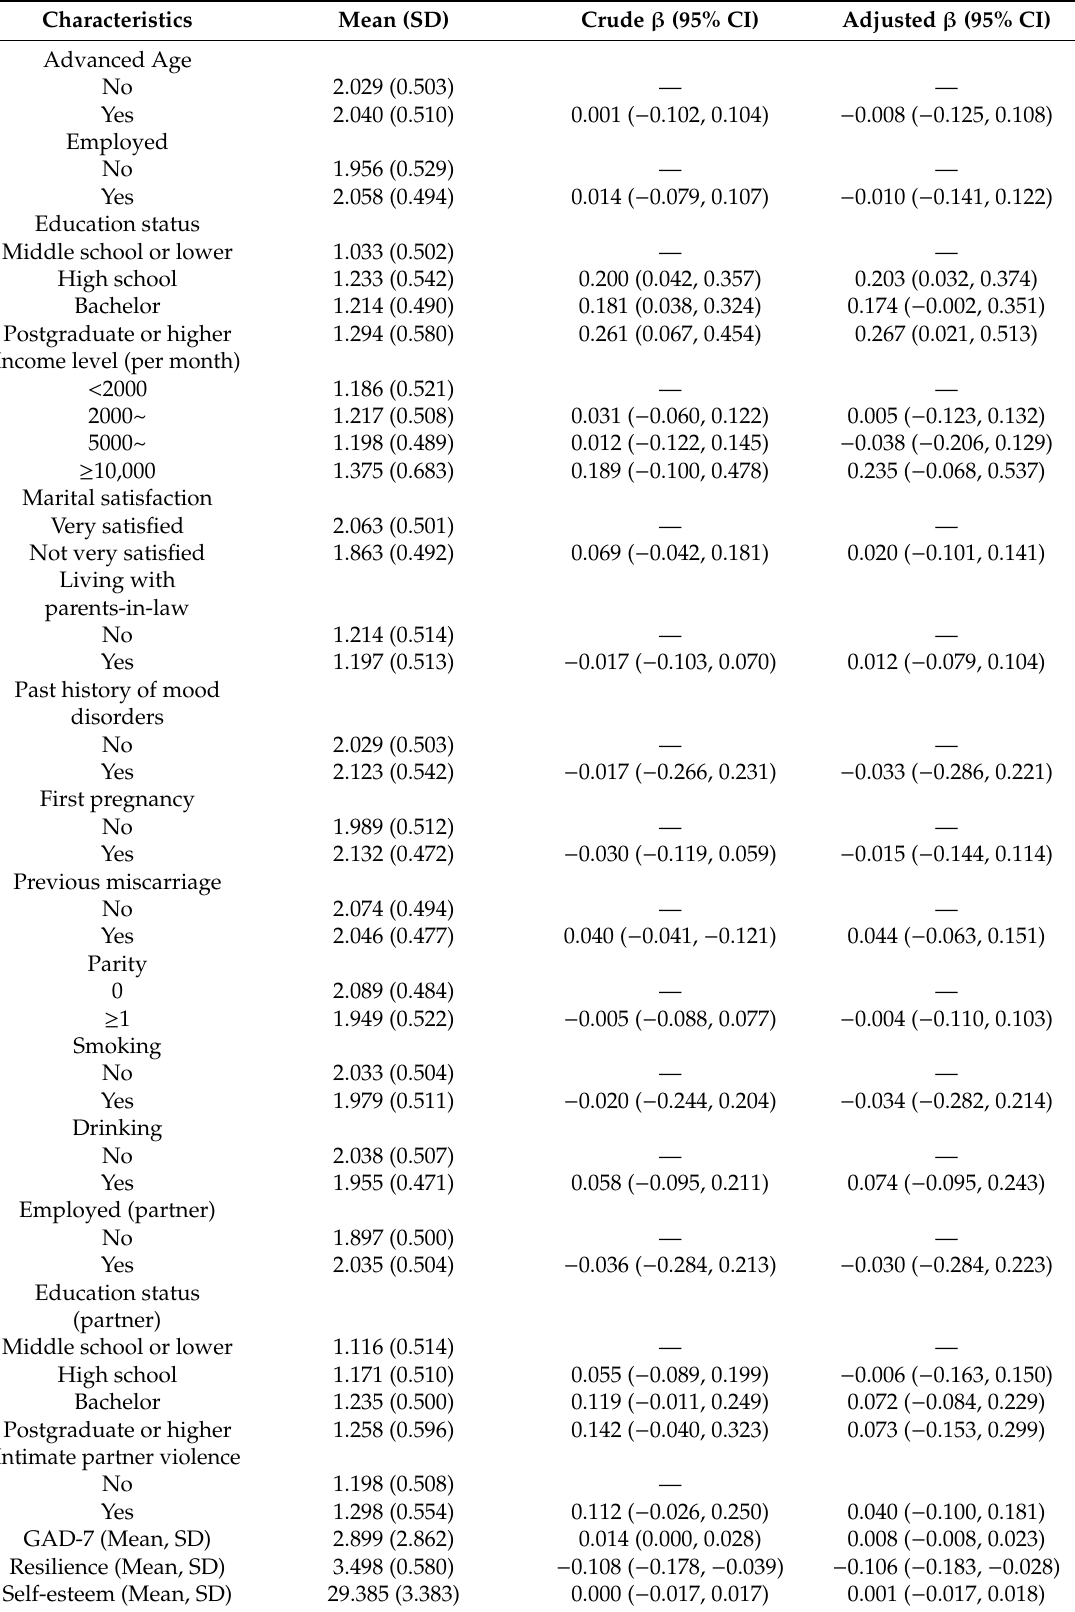
Table 4. Influencing factors of negative